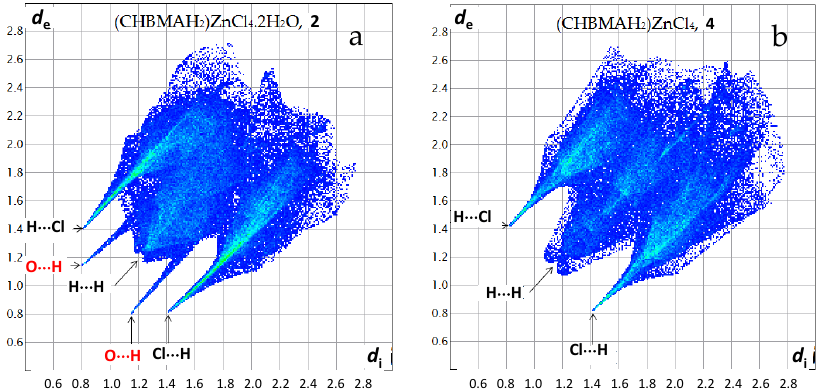
Figure 8. Comparison of fingerprint plots for ( a ) hydrated compound 2 and ( b ) dehydrated com- pound 4 .